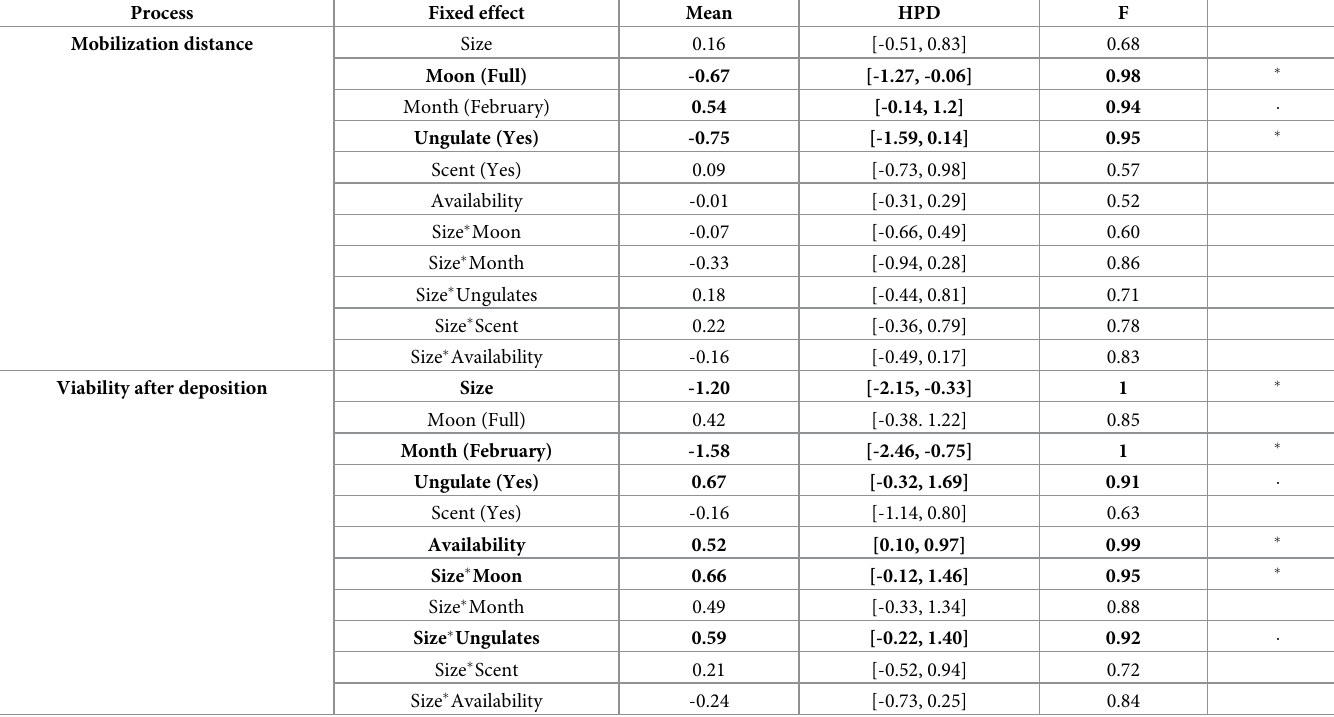
Table 2. Summary table of the effects of size, moonlight, month, ungulate presence, predator scent and local acorn availability (and their interactions with size) on acorn mobilization distances and the probability that it is deposited in a viable status (vs predated). A total of 211 acorns that were mobilized outside cages and retrieved were